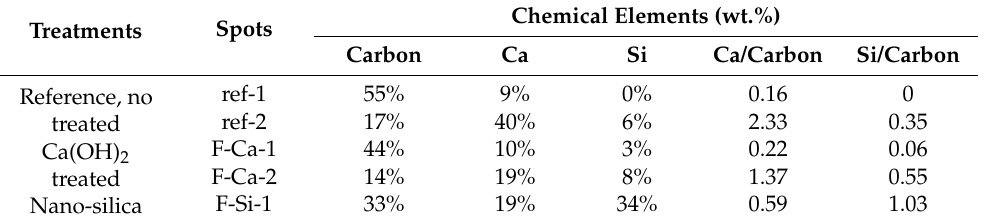
Table 4. Chemical compositions around ITZs. The spots corresponding to the specified regions in Figure 8.